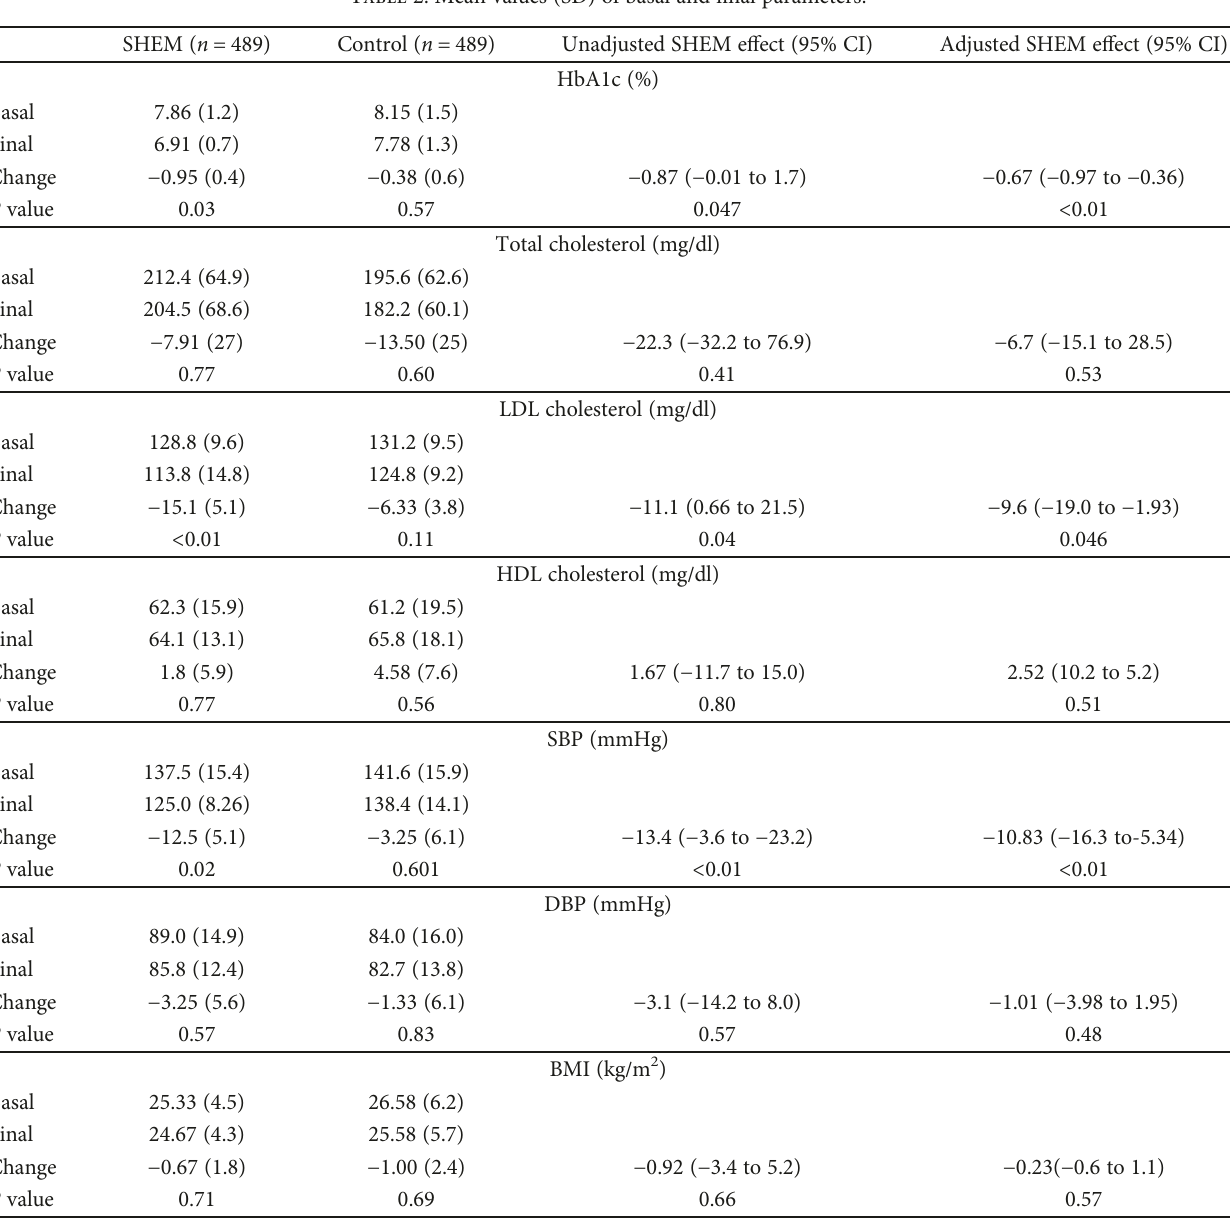
Table 2: Mean values (SD) of basal and fi nal